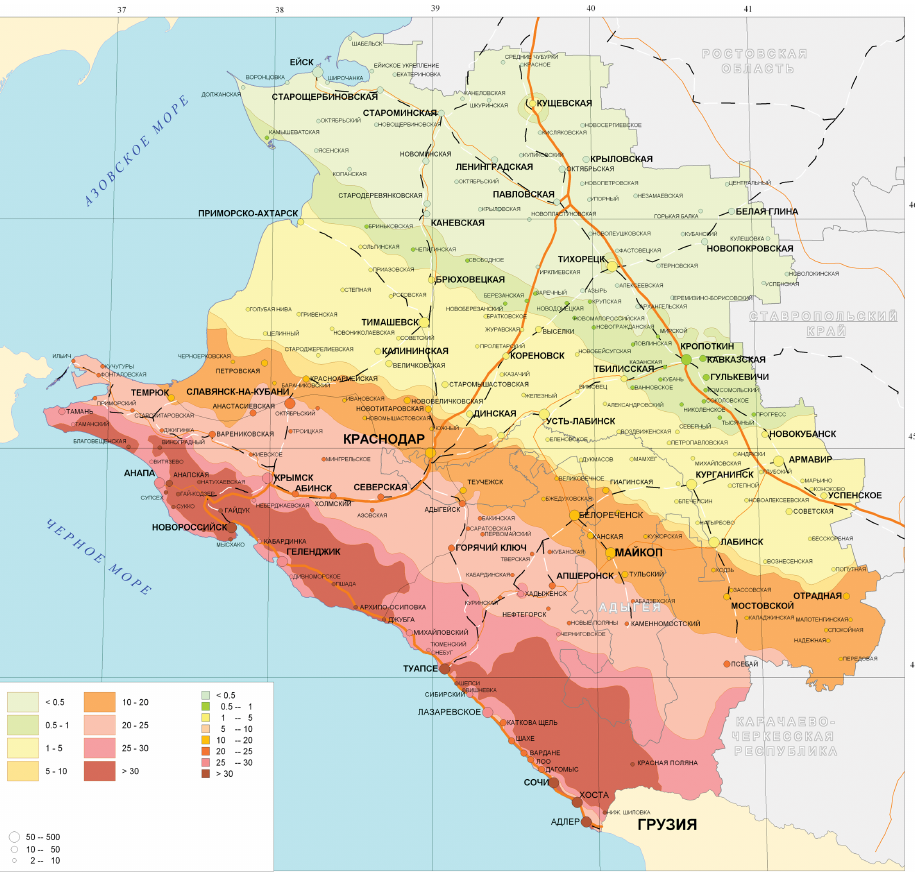
Fig. 2. Map of seismic risk R st 1, 10 − 5 yr − 1 zoning for the territory of the Krasnodar region, taking into account technological accidents triggered by